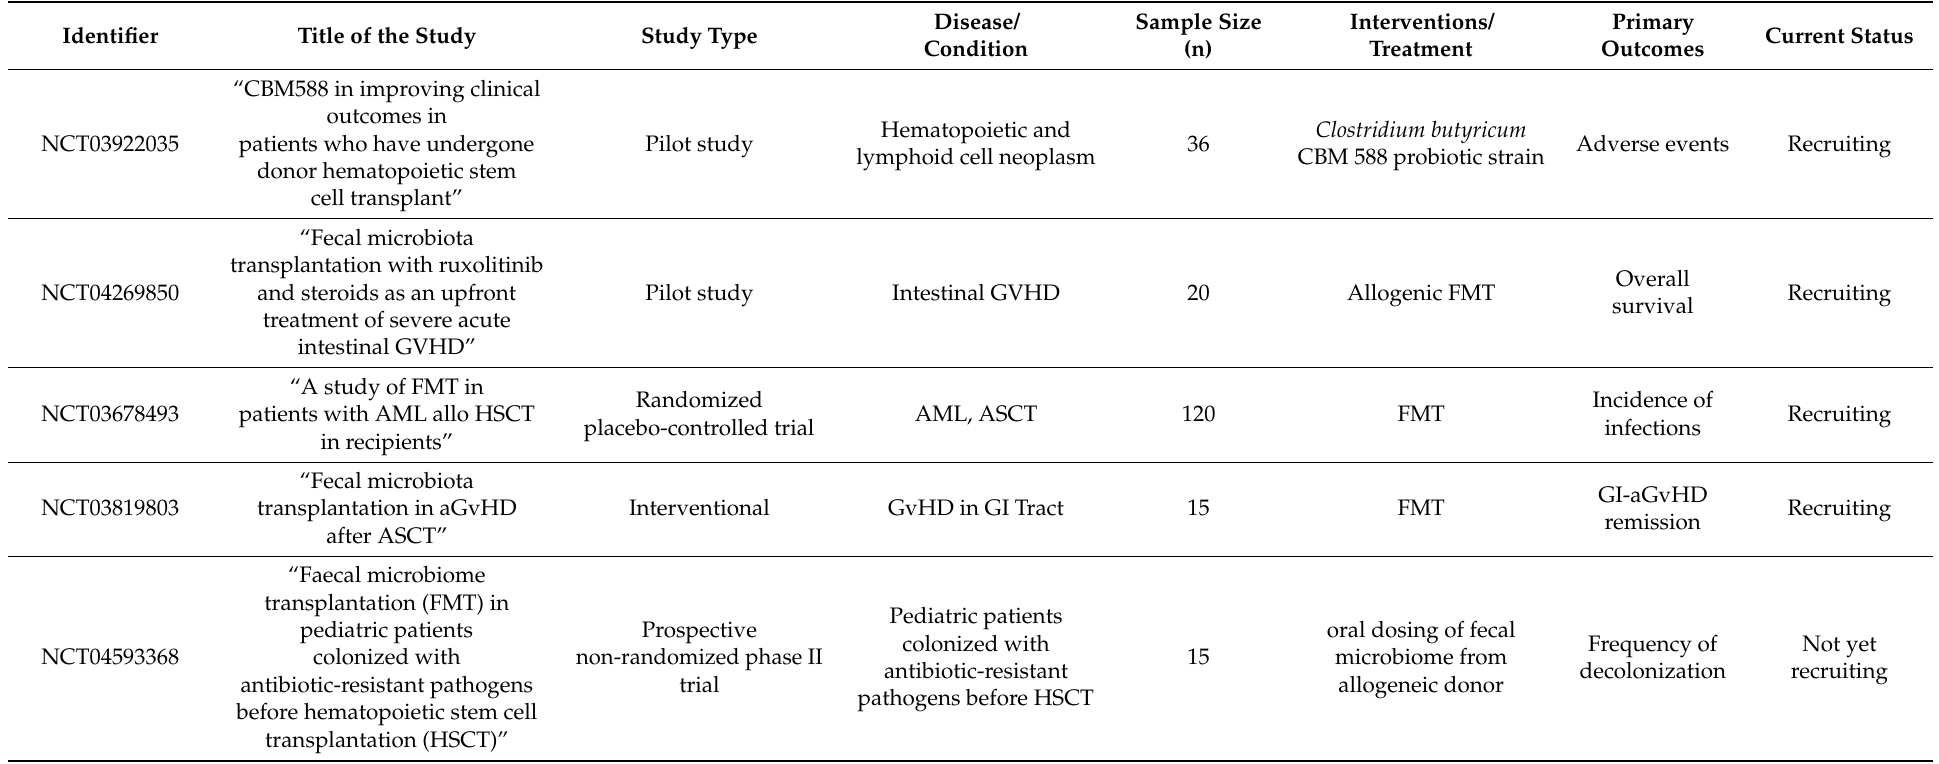
Table 2. Future perspective of therapeutic modification of gut microbiota in patients with hematologic diseases. Selected recruiting/not yet recruiting trials registered in ClinicalTrials.gov (accessed on 12 February